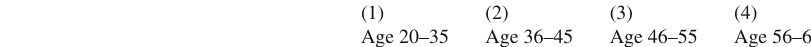
Panel A: Gross annual labor earnings in the top quantile of the ECPF